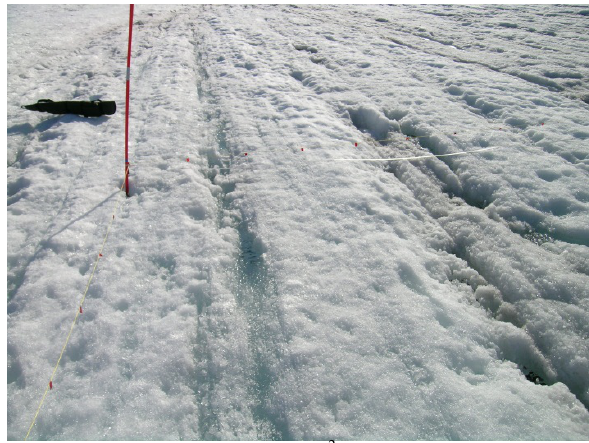
Figure 2. One of the 4 m 2 area photographs